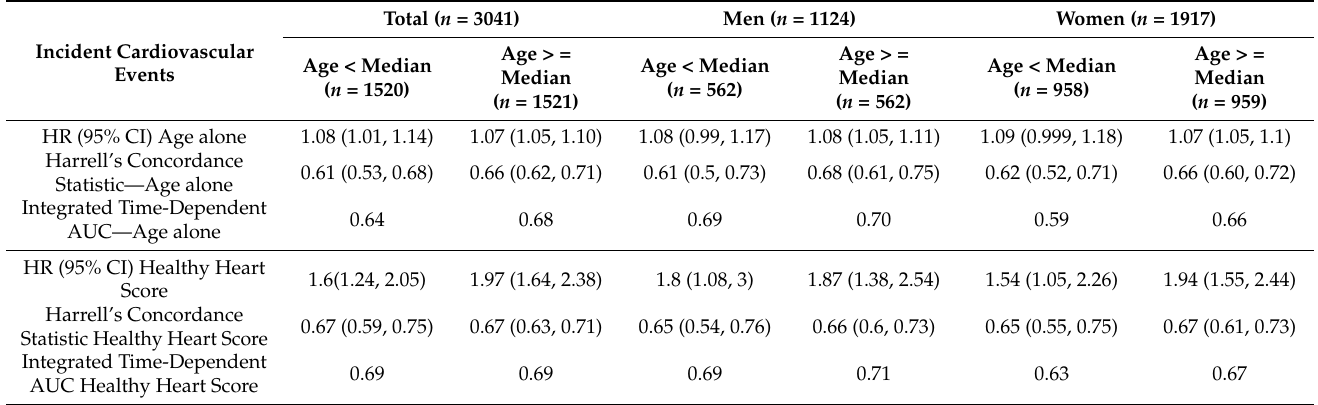
Table 3. Model performance of the Healthy Heart Score in the Jackson Heart Study for Cardiovascular Events according to median of age for the overall cohort, men and women, (a) age only model; (b) Healthy Heart Score. Incident Cardiovascular Events